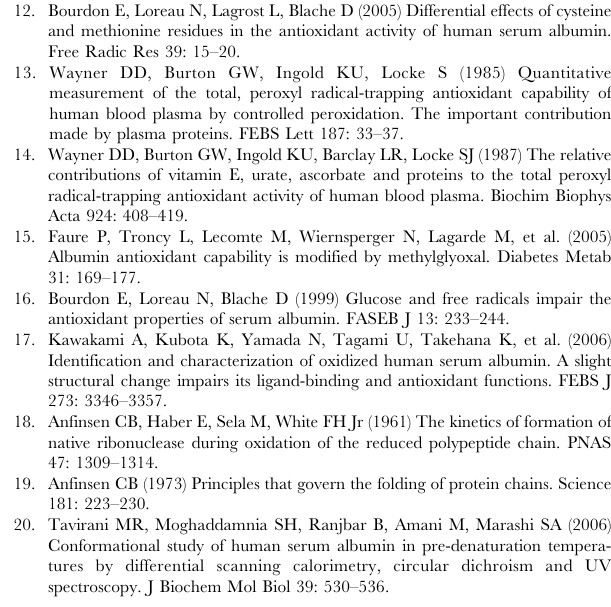
Figure S1 Antioxidant capacity and protein half life. Three proteins tested (human insulin, bovine albumin and carbonyc anhydrase) presented an inverse relationship between antioxidant capacity and the protein 9 s half life. Antioxidant Capacity as Trolox nM concentration used as standard (Trolox Equivalent Units.